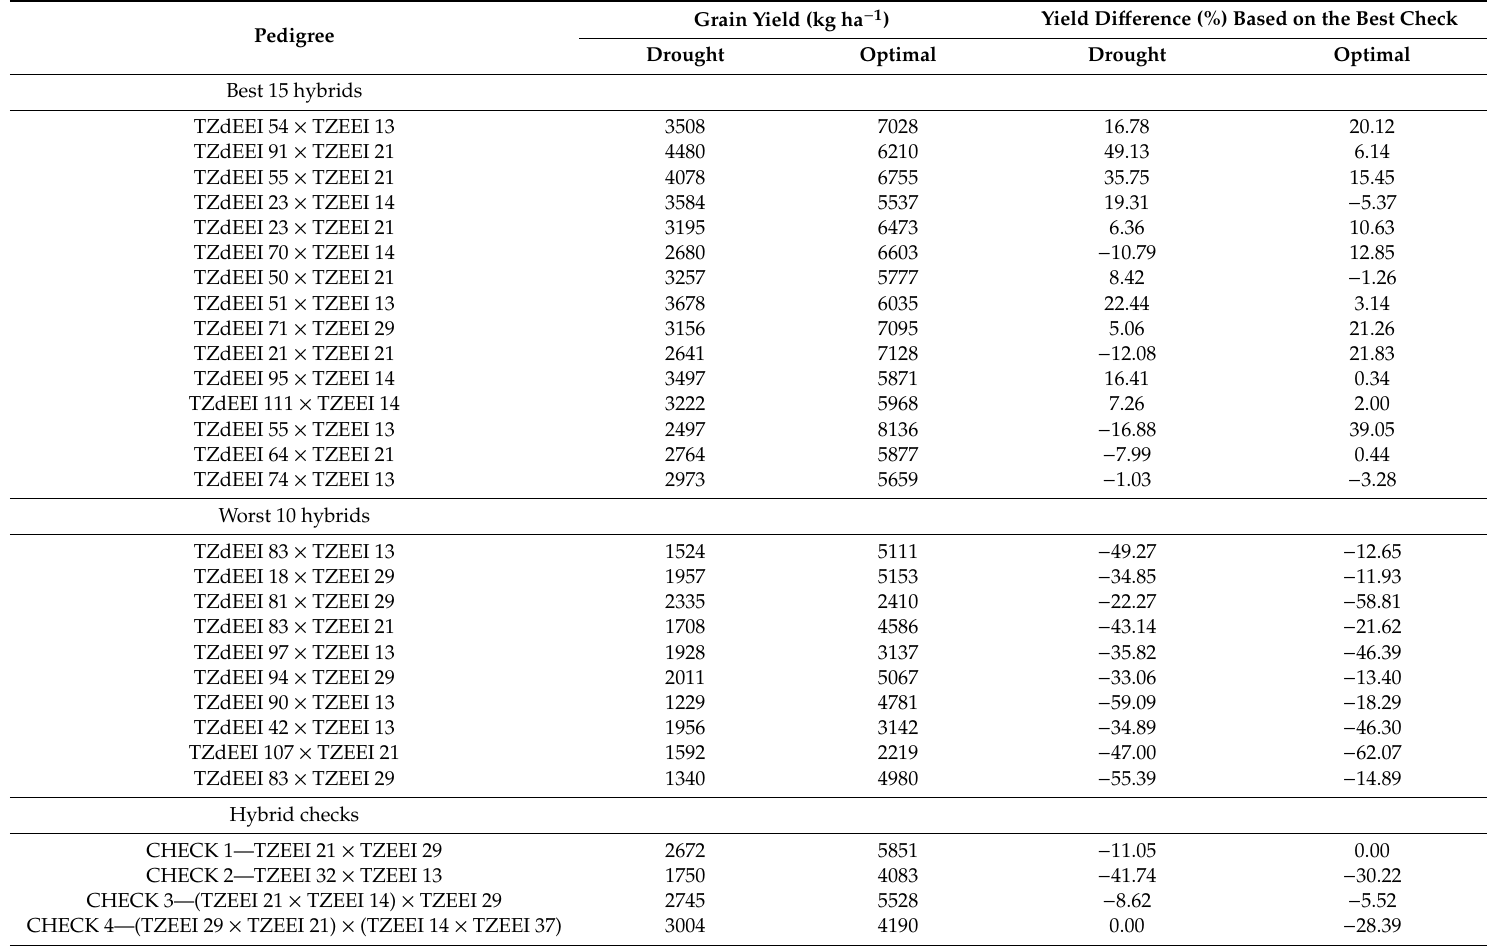
Table 3. Grain yield and yield reduction or increase based on the best check under drought and optimal conditions (best 15 and the worst 10). Grain Yield (kg ha − 1 ) Yield Di ff erence (%) Based on the Best Check Pedigree Drought Optimal